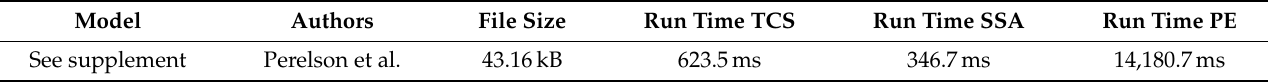
Table 1. Use case for a kinetic model analyzed with the SBMLWebApp (TCS: time-course simulation, SSA: steady-state analysis, PE: parameter estimation). All measurement results were the median of 10 measurements. The analysis conditions were the default settings of SBMLWebApp. The results in this table were achieved using a server with 16 CPUs of type AMD Ryzen 7 2700X Eight-Core Processor, each of which had 1882.649 MHz and a cache size of 512kB. Model Authors File Size Run Time TCS Run Time SSA Run Time PE See supplement Perelson et